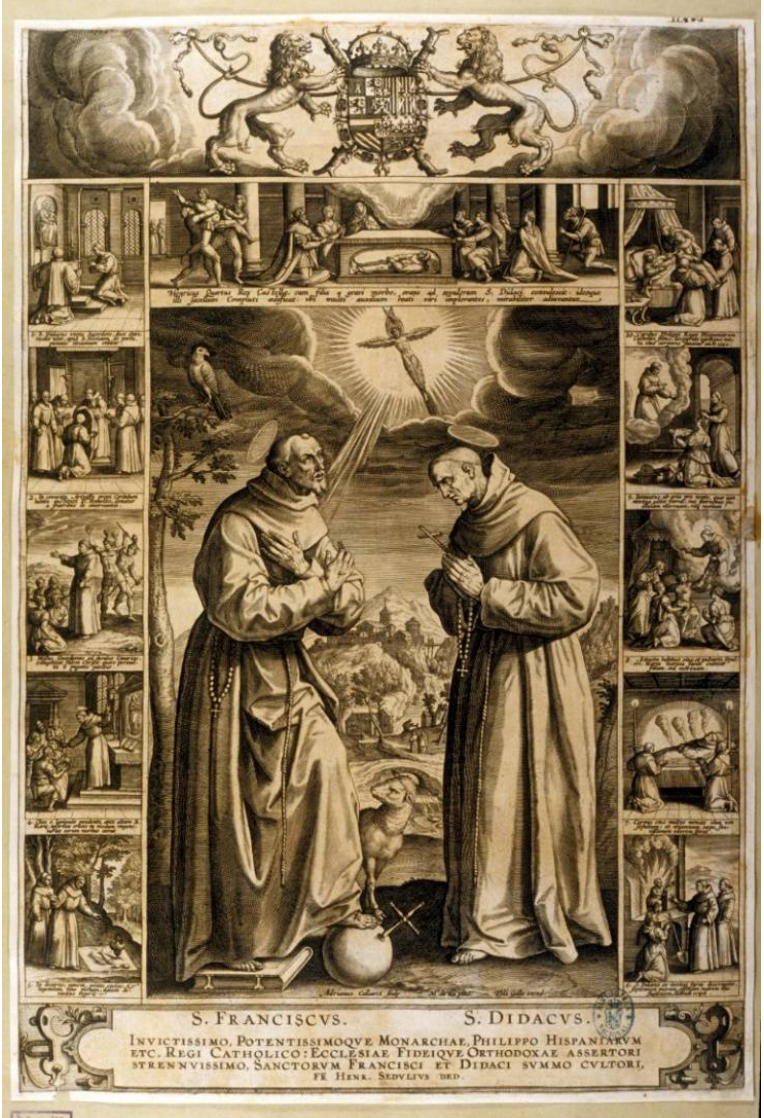
Figure 3. Adriaen Collaert (engraver) and Philips Galle (printer) after Maarten de Vos. S. Franciscus, S. Didacus. Dedication by Henrik Sedulius. ca. 1600–1618. Engraving on paper. 422 × 288 mm.